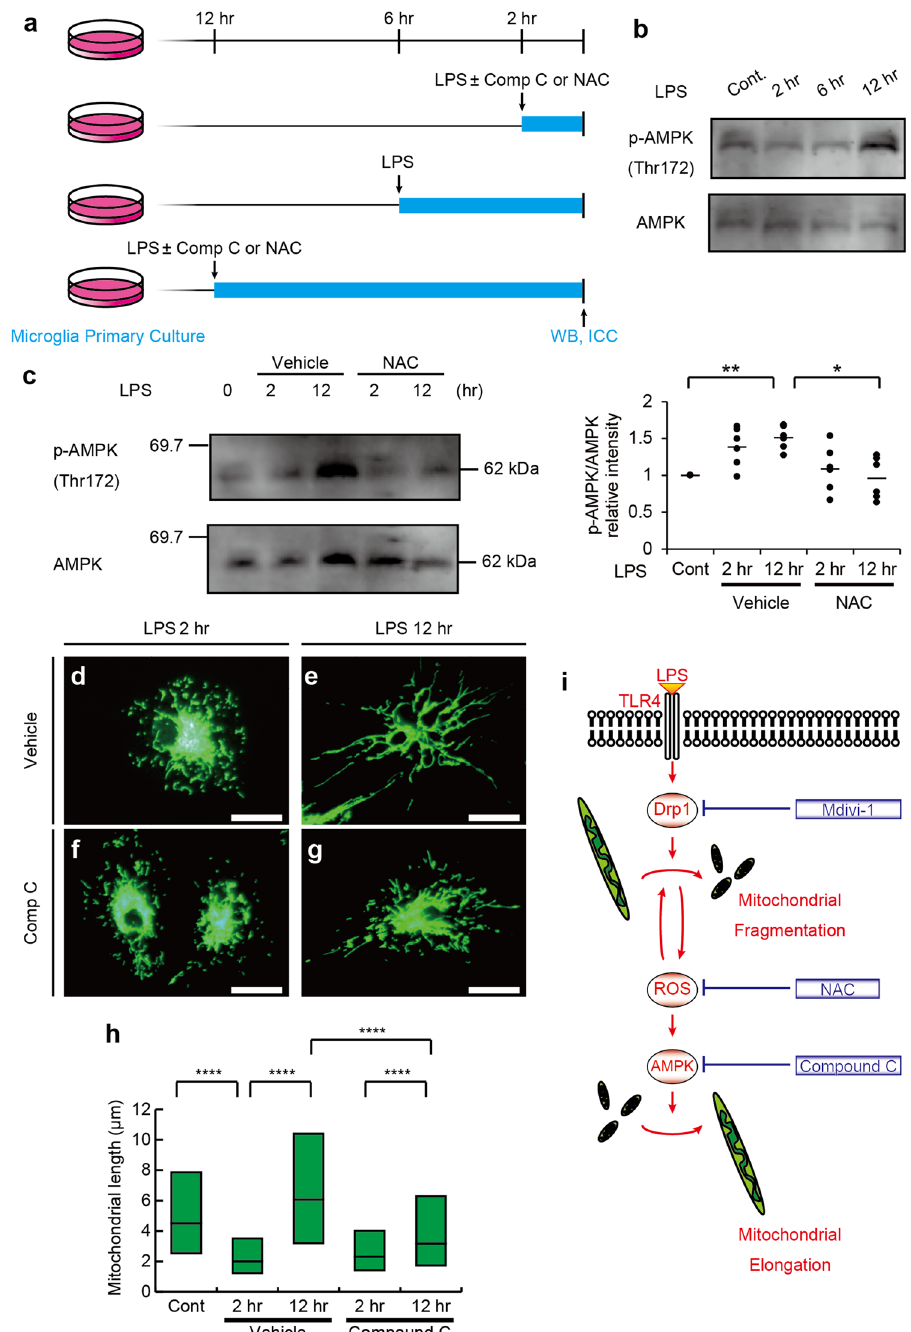
Figure 8. Mitochondrial elongation after a 12 hr stimulation with lipopolysaccharide (LPS) is mediated by reactive oxygen species (ROS) and activated AMP-activated protein kinase (AMPK). Primary microglial cultures were untreated (Cont) or treated with LPS for 2 (2hr) or 12 (12hr) hr with or without drugs including a ROS scavenger (N-acetyl cysteine; NAC) and Compound C (Comp C), and then subjected to Western blotting and immunostaining for TOM20 ( a ). Western blotting of AMPK phosphorylated at Thr172 (p-AMPK) and total AMPK following LPS stimulation ( b ). Western blotting of p-AMPK with or without NAC treatment ( c , left) and quantification of the western blotting analyses ( c , right) are shown. * p < 0.05, ** p < 0.01 in t-test (N = 6). Each dot represents each replicate and means (bars) are shown. Representative images ( d–g ) and the measured lengths ( h ) of TOM20-immunopositive mitochondrial profiles with or without treatments of NAC ( h ). The graphical summary of the model is shown ( i ). N = 1818 (control), 3489 (LPS 2hr), 2238 (LPS 12hr), (LPS 2hr + Comp C) and 3654 (LPS 12hr + Comp C) mitochondria in ( h ). **** p < 0.0001 in the U -test. Medians ( h , bars) with quartile ranges ( h , boxes) are shown. Bars: 20 μ